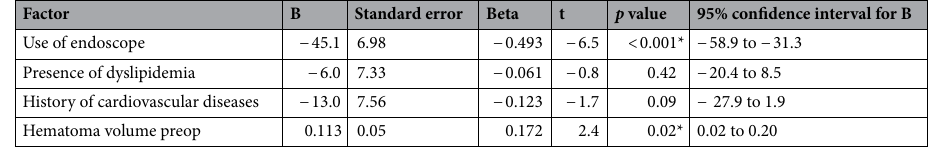
Table 5. Multiple regression analysis for factors associated with operative time. Multiple regression analysis was performed using the factors selected by univariate analysis with p < 0.10 and |r|> 0.20; use of the endoscope, presence of dyslipidemia, history of cardiovascular disease, and preoperative hematoma volume. B, coefficient. * p < 0.05 by multiple regression